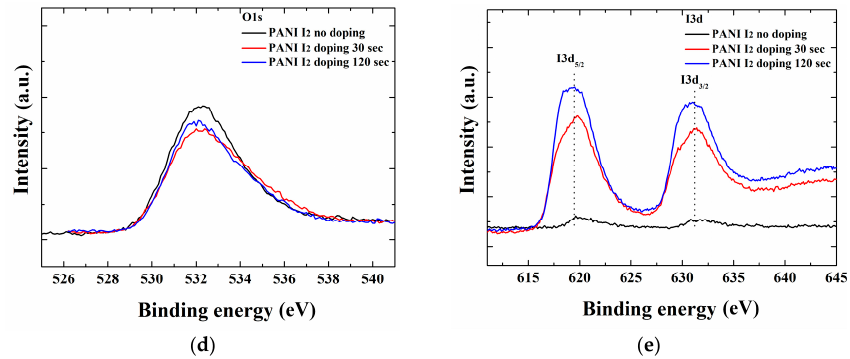
Figure 6. Differences in PANI film surfaces grown on glass substrates when using advanced APPJs device after 60 min deposition without I 2 doping, with 30 s I 2 doping, and with 120 s I 2 doping following deposition: ( a ) X-ray photoelectron spectroscopy (XPS) survey spectra; and detailed ( b ) C 1s (high-resolution); ( c ) N 1s (high-resolution); ( d ) O 1s; and ( e ) I 3d spectra. Insets in ( a ) represent atom percent in PANI film. Table 1. Peak assignment (BE, eV) and envelope composition (%, total = 100) of various C 1s core level spectra of polymerized aniline (PANI) observed in X-ray photoelectron spectroscopy (XPS) spectra in Figure 6b.